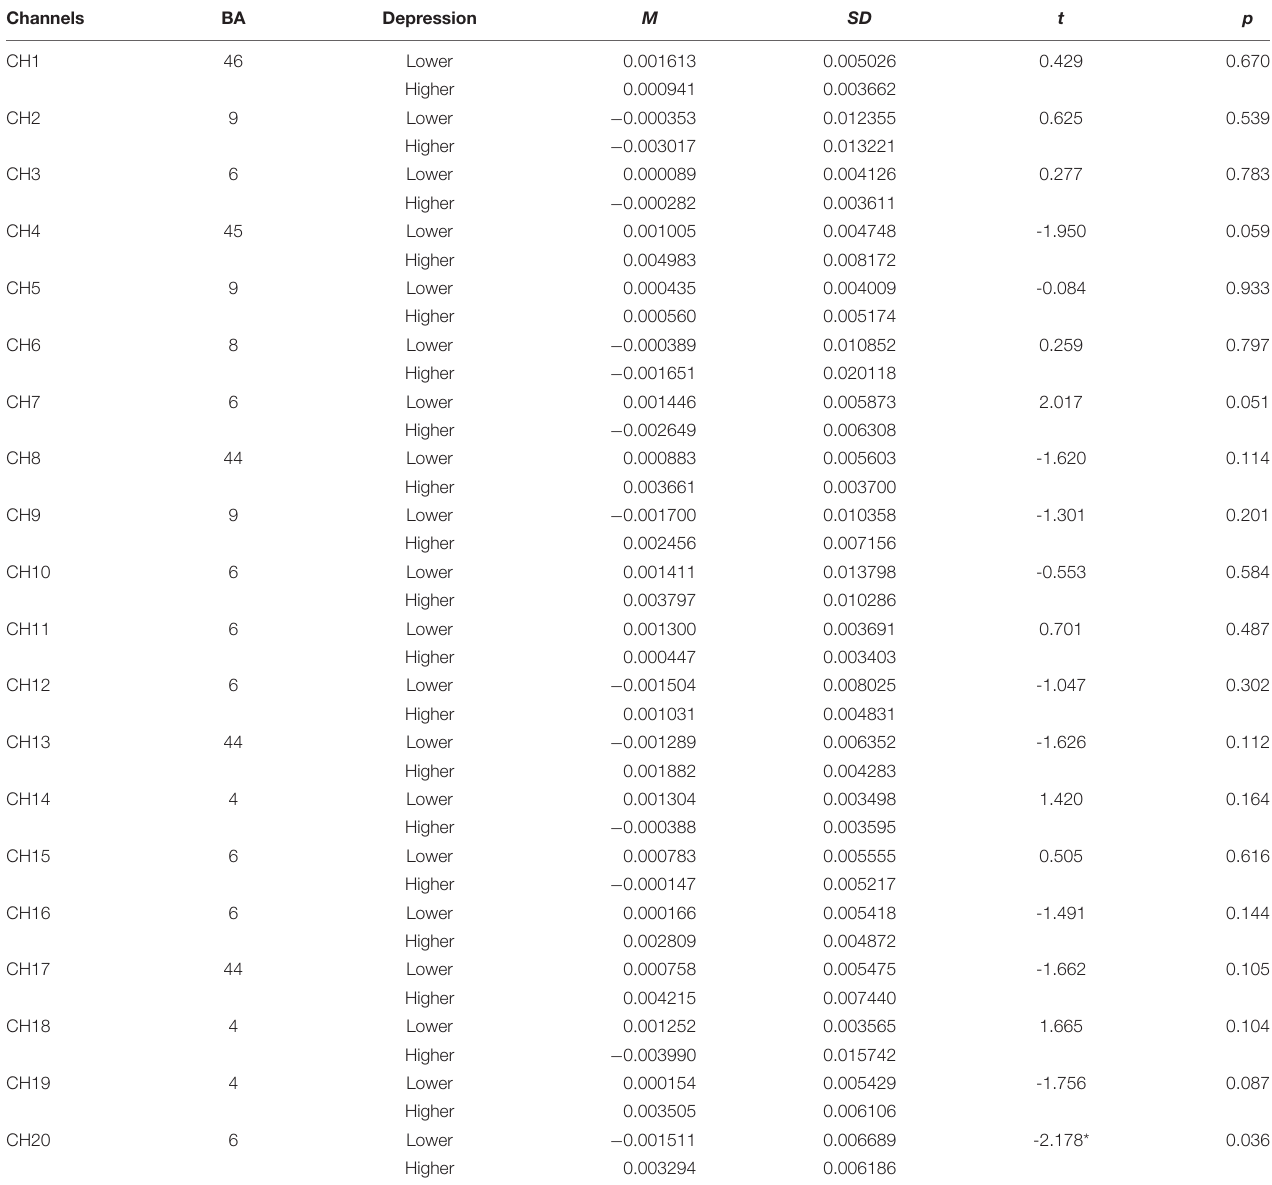
TABLE 5 | The comparison of brain activation between higher and lower groups in perceptual stage for subject mirrored images (HbO).